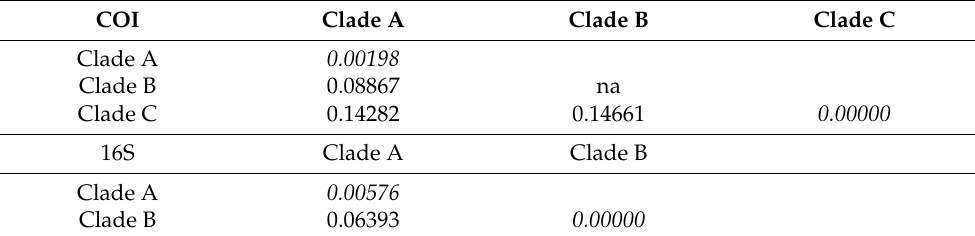
Figure 2. Phylogenetic tree obtained with the 16S sequences. Near the nodes are the support values for the Bayesian interference (BI), maximum likelihood (ML), and neighbor-joining (NJ) methods. PAC, Pacific Ocean; ATL, Atlantic Ocean. Table S1 contains all details and references of the sequences used. In blue are the Tremoctopus sequences from the Mediterranean Sea. Next to the tips are the GenBank accession numbers, under which the sequences are deposited in the repository, and their geographical origins. The letters near the tree (A and B), indicate the clades. Table 2. Genetic distances among the Tremoctopus groups identified in the trees, calculated in MEGA in the Kimura two-parameter model [36]. Intra-group distances are shown in the diagonal in italic, while inter-group distances are shown below the